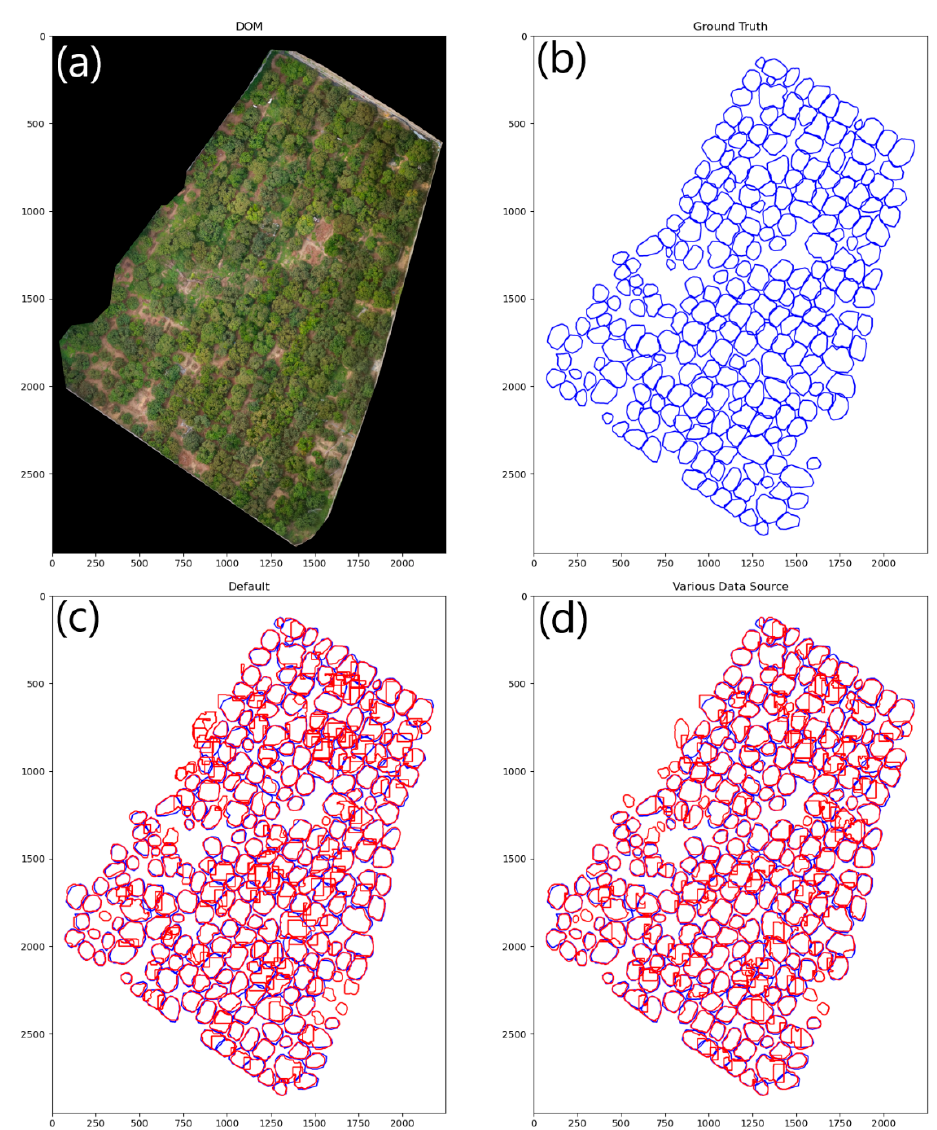
Figure 9. Visualization of the model’s inference results. ( a ) The DOM of Area B. ( b ) The annotation of ground truth with blue lines. ( c , d ) The inference results of the models with red lines. Row a in Figure 10 indicates that both models can segment the canopies well when the trees are not dense. When inferring the position shown in Row c, the default model tends to generate overlapping masks, but the best model does